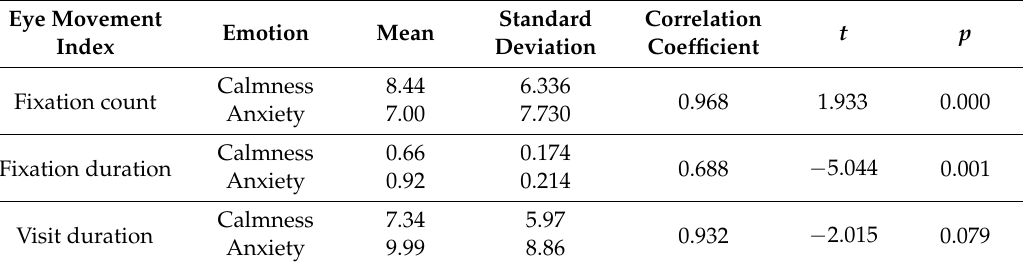
Table 4. Paired sample t -test for drivers’ eye movement characteristics.